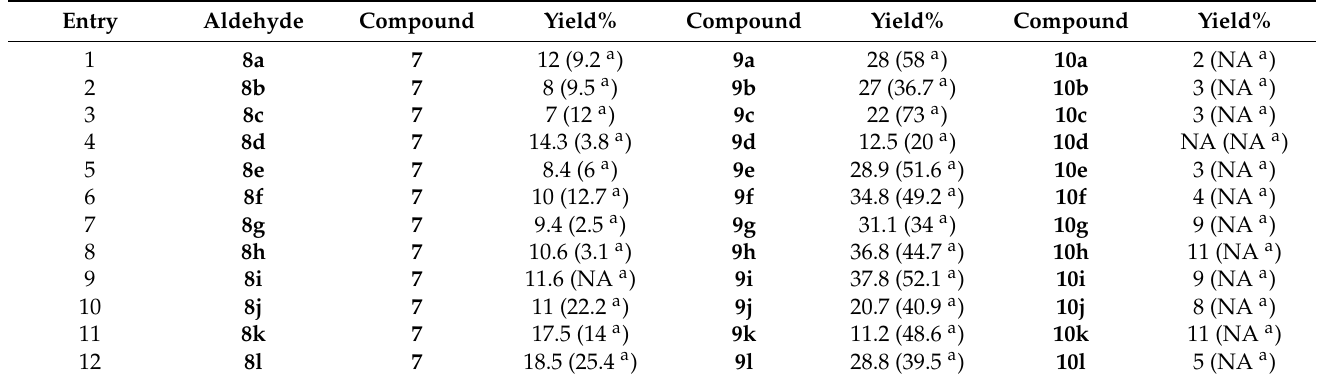
Table 1. Yields of products for the synthesis of asymmetric curcumin analogues 9a – l from compound 6 in condensation with aldehydes 8a – l in Scheme